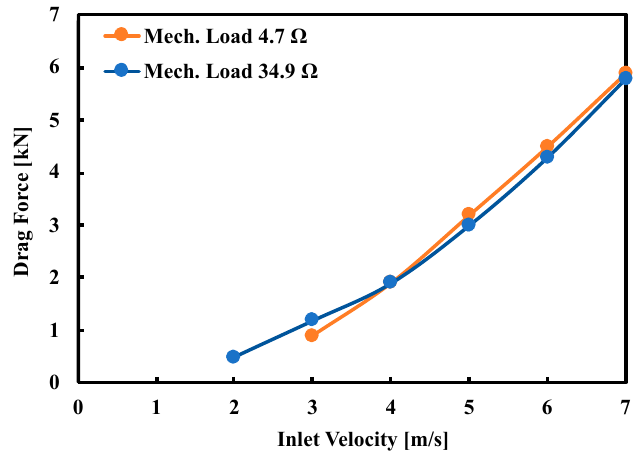
Energies 2020 , 13 , x FOR PEER REVIEW Figure 21. Rotational speed and inlet velocity co-relation. Figure 21. Rotational speed and inlet velocity co-relation. Figure 21. Rotational speed and inlet velocity co-relation.